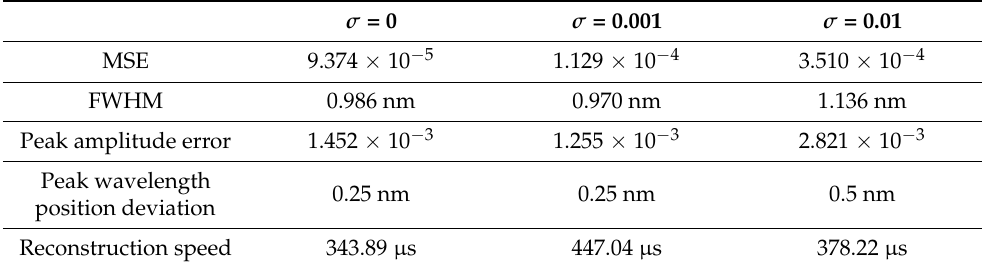
Table 1. Mean value of WER-Net performance index.